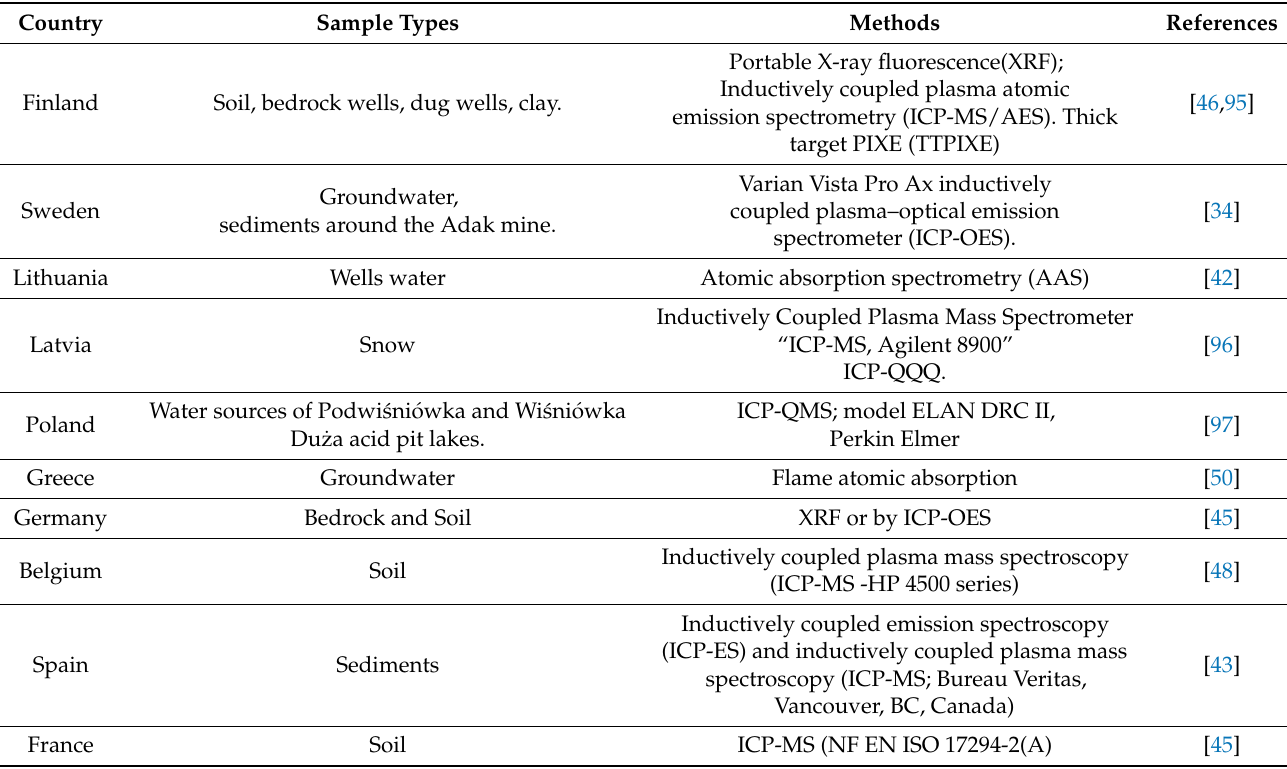
Table 9. Arsenic detection methods used by different countries [34,42,43,45,46,48,50,95–97].